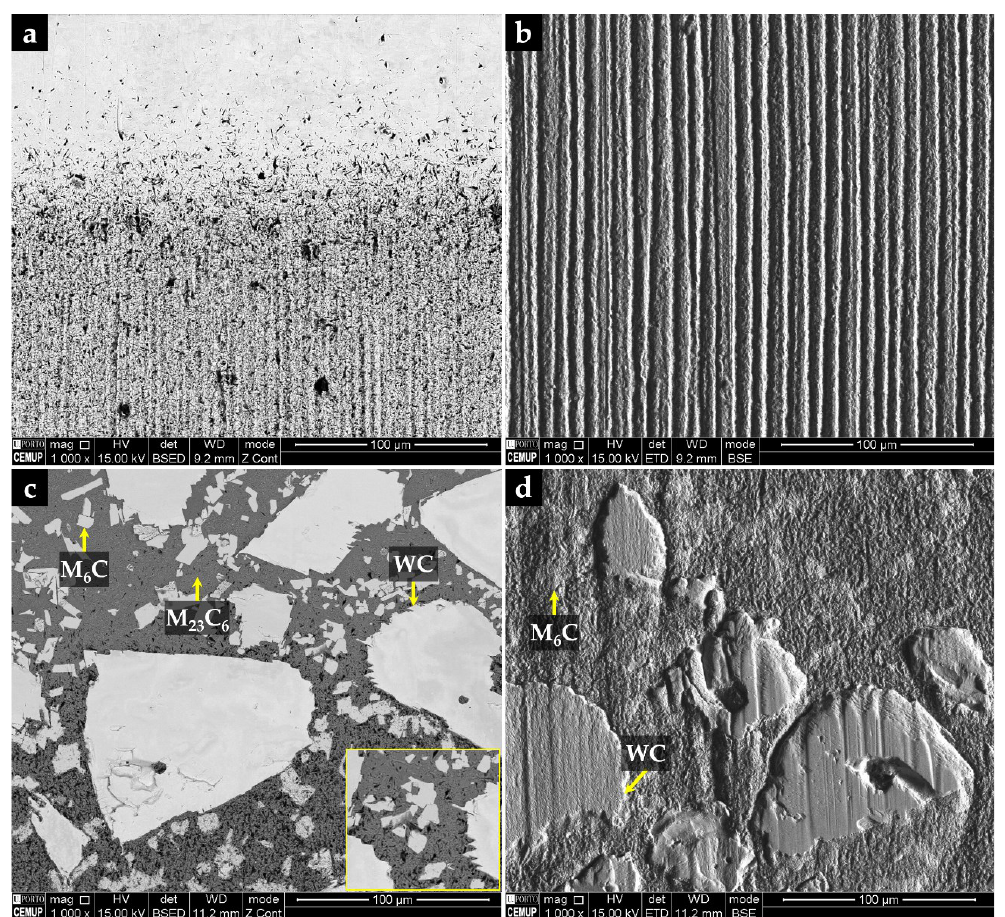
Figure 9. SEM images of the wear craters after a sliding distance of 31.4 m: ( a , b ) base metal, ( c , d ) the WC – MMC; ( a , c ) are regions close to the edge of the crater, and ( b , d ) are regions of the surface of the crater.